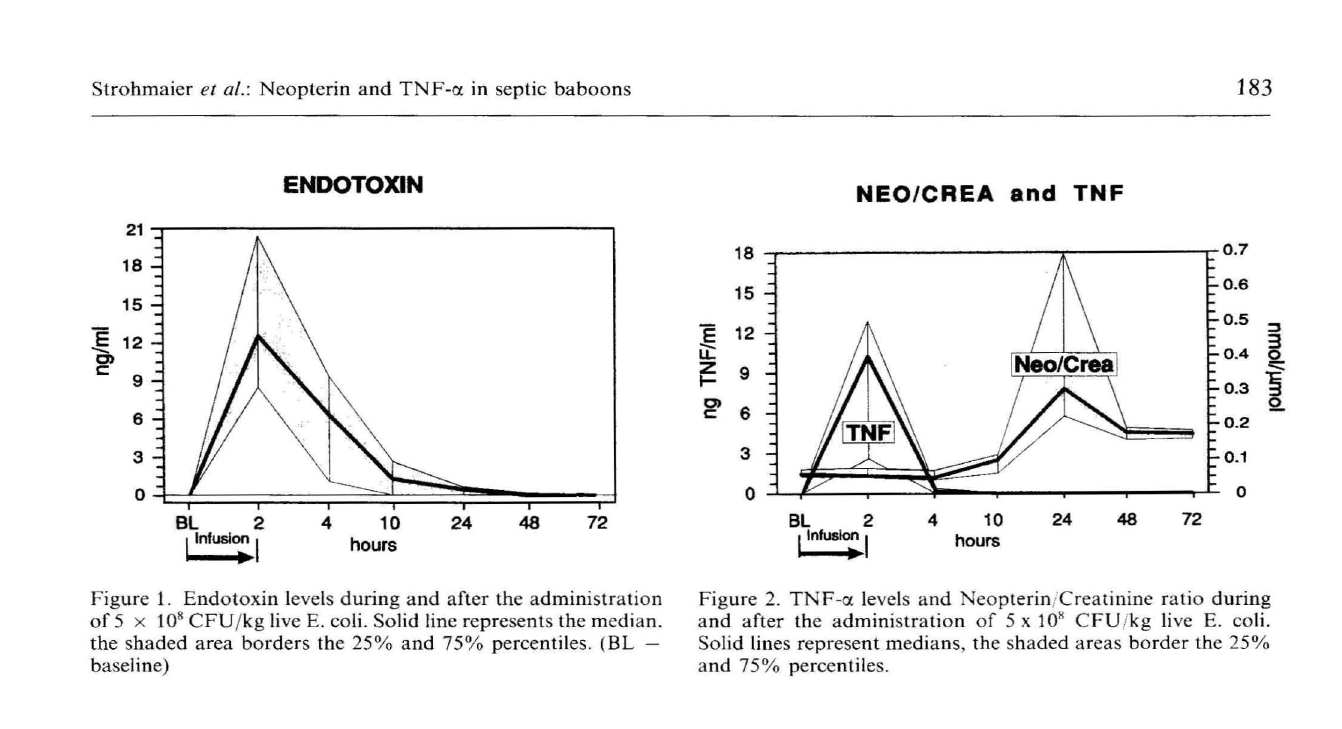
Figure 2. TNF-« levels and NeopterinjCreatinine ratio during and after the administration of 5 x 10" C FU/kg live E. coli. Solid lines represent medians, the shaded areas border the 25% and 75%